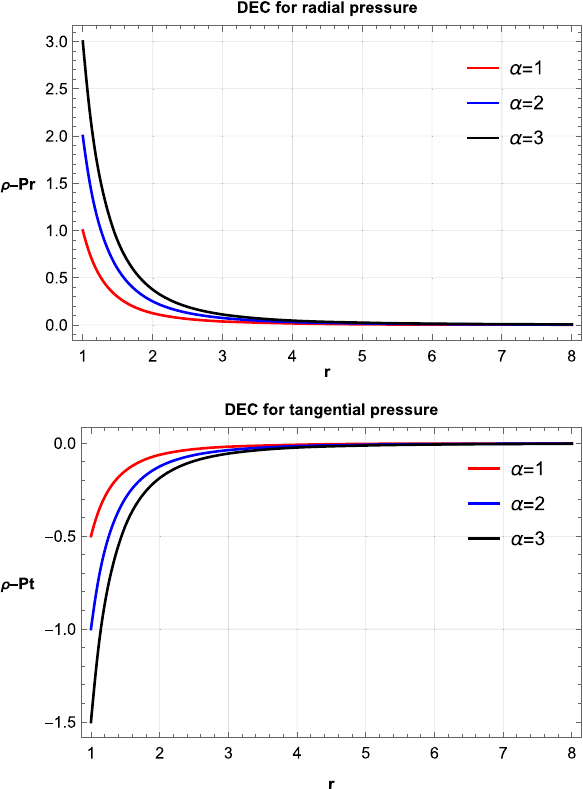
Fig. 11 The variation of NEC against r for two sphere (case-1) with r 0 = 1 and A = 0 . 05